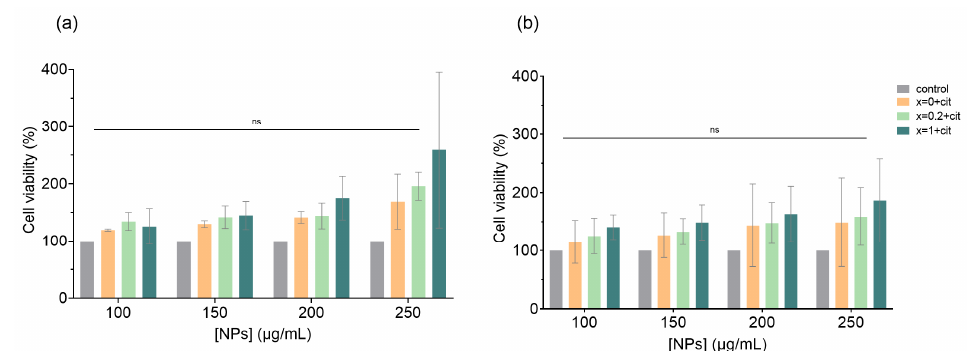
Figure 5. In vitro cytotoxicity in HEK 293T cells of citrate-functionalized Ca-Mn ferrite NPs. Cell viability was assessed by MTT assay in HEK 293T cells incubated with four different concentrations of NPs (100, 150, 200, 250 µg/mL) for 24 h ( a ) and 48 h ( b ). Untreated cells at 24 h and 48 h were used as a negative control (100% viable cells). Data are expressed as the mean of three independent experiments ( n = 3). Two-way ANOVA assessed by Tukey’s multiple comparison test indicates no statistically significant differences between the groups tested, denoted as ns p > 0.05. Abbreviations: x = 0 + cit, x = 0.2 + cit and x = 1 + cit are citrate-functionalized MnFe 2 O 4 , Ca 0.2 Mn 0.8 Fe 2 O 4 and CaFe 2 O 4 nanoparticles,